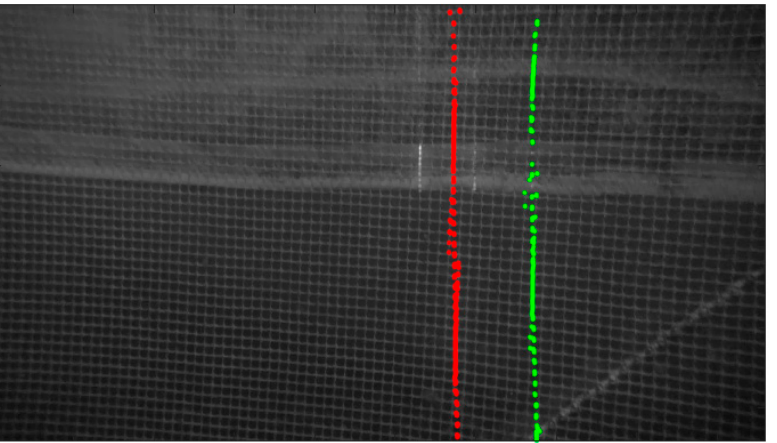
Figure 9. The laser line detection in the picture in Figure 10. The two brightest laser lines are found even when two extra less bright laser lines appear on a more distant net.